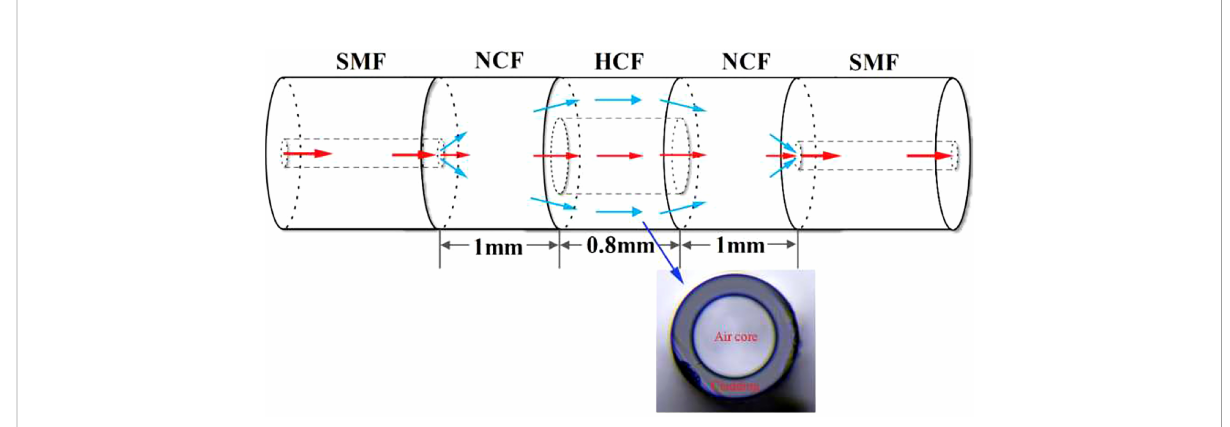
FIGURE 5 Schematic diagram of a SNHNS structure and picture of a cross-section of the hollow-core fi ber (from Yin et al.,